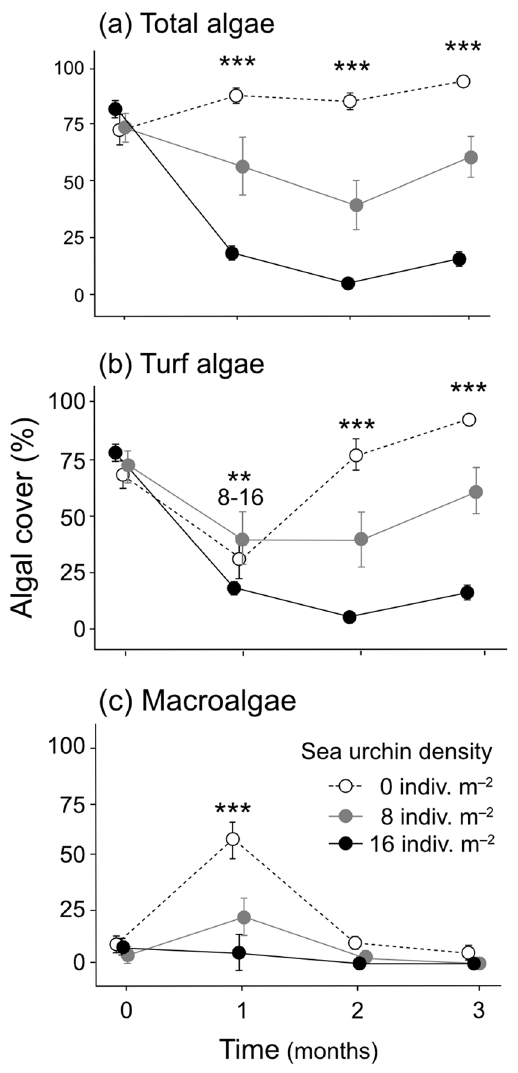
three density conditions at the 1st month. Datapoints were slightly shifted horizontally to avoid